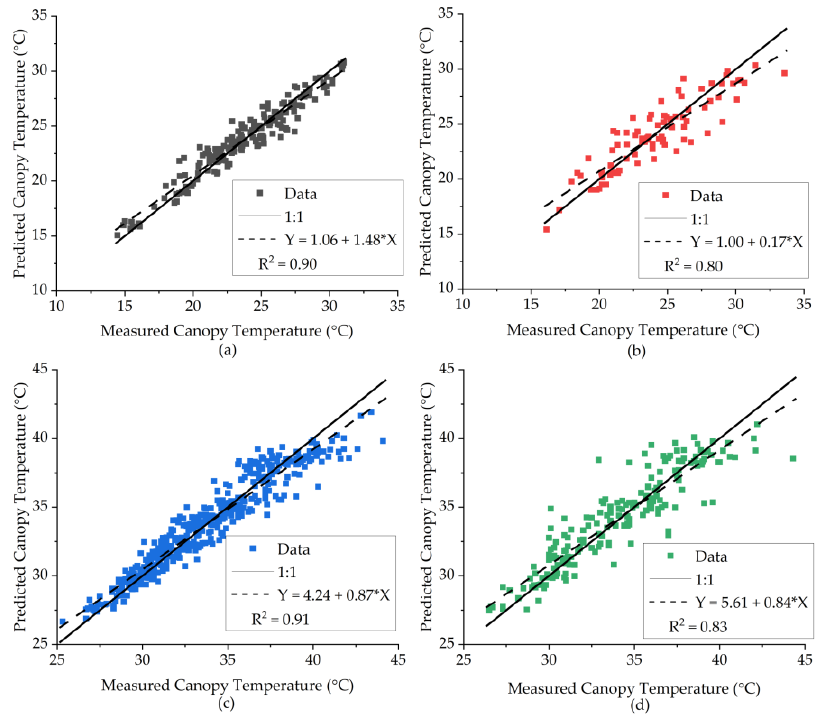
Figure 9. The performance of the model in predicting T wet in terms of the ( a ) development and ( b ) validation in E1 and the ( c ) development and ( d ) validation in E2.